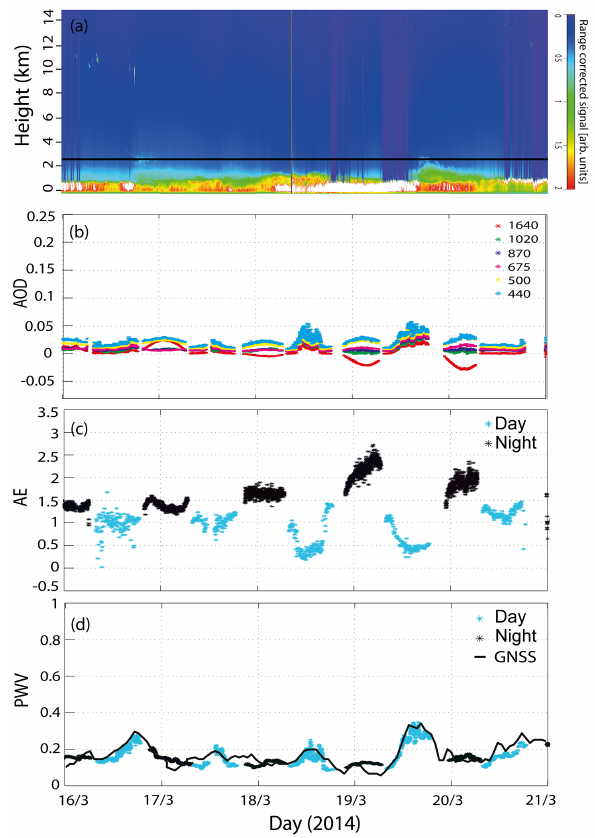
Figure 12. Case study at IZO in March 2014, including informa- tion for (a) MPL-corrected backscatter cross section obtained from Santa Cruz de Tenerife station (60ma.s.l.). The black horizontal line represents the altitude of IZO station. Grey vertical lines repre- sent the absence of measurements. The evolution of CE318-T AOD, AE and PWV from 16 to 21 March 2014 is shown in (b) , (c) and (d) . PWV values from GNSS precise orbits are plotted with a black solid